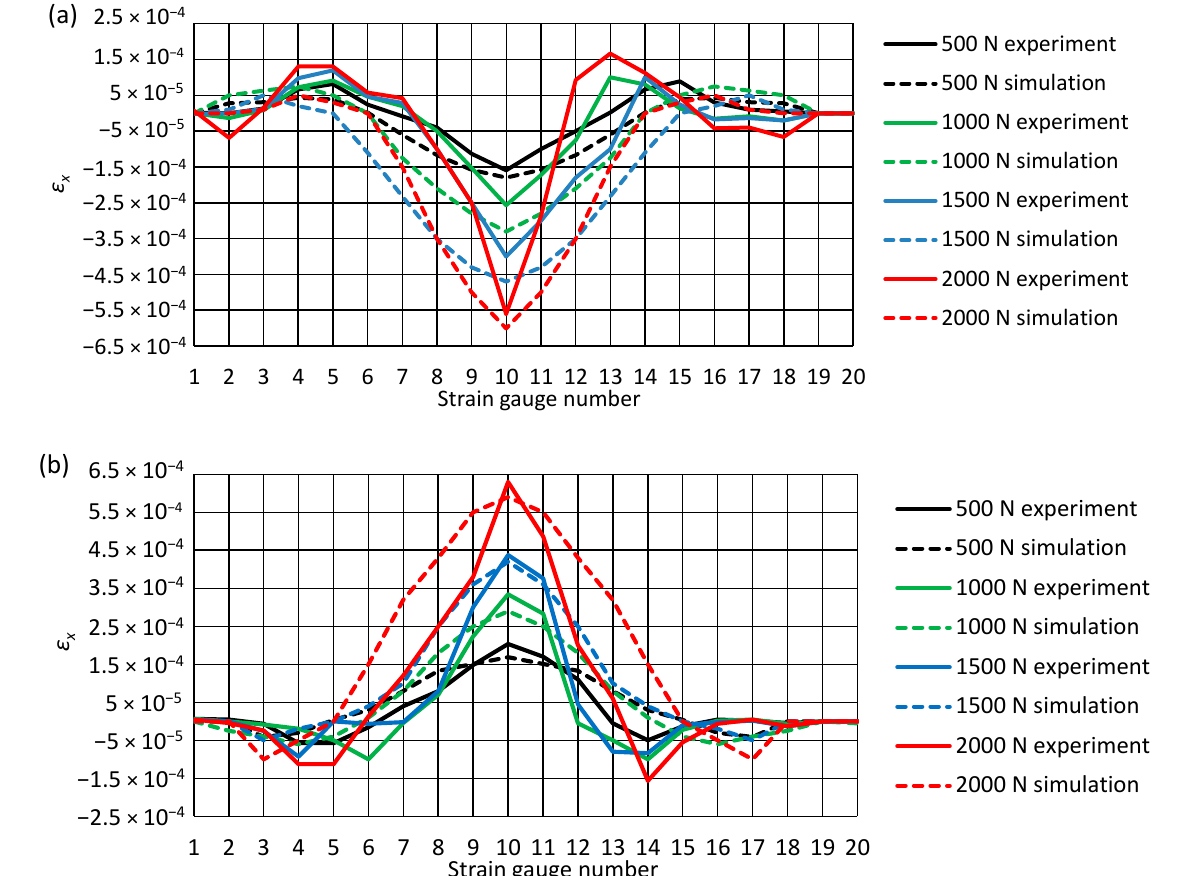
Figure 10. Longitudinal deformations of the pipe ε x at different external loads: ( a ) top of the pipe, ( b ) bottom of the pipe.